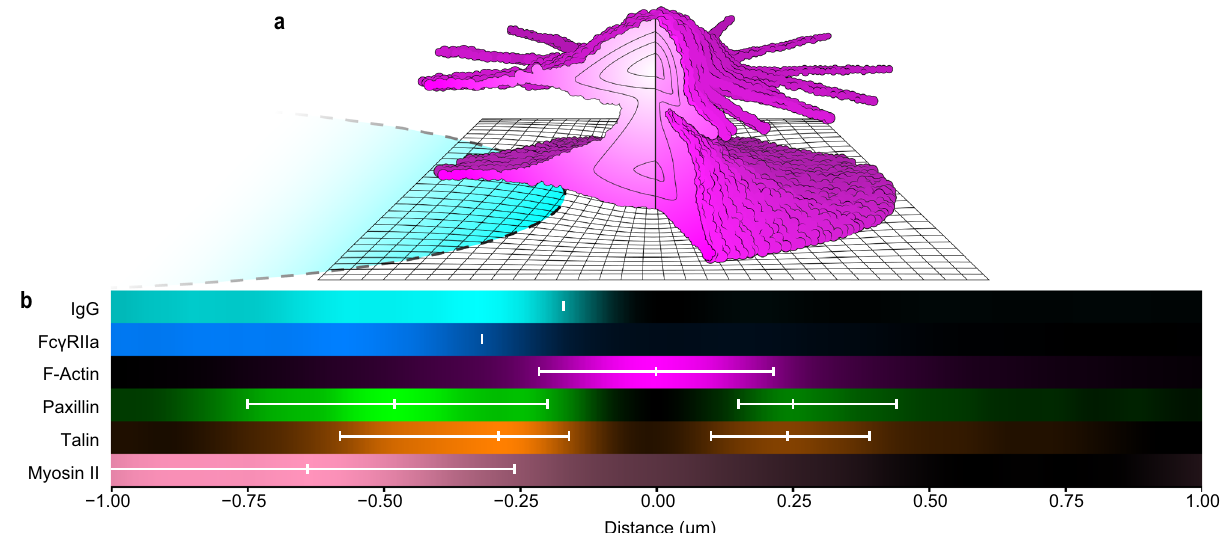
Fig. 9 | Schematic of podosome constituents drawn to scale. a Cartoon of actin (magenta) based on iPALM, showing upper radial fi bers, lower actin network, and the ventral protrusion. The cross-section shows intensity contours quanti fi ed in Fig.4e.The IgGdisk is shown incyan. Grid unitlength=50nm. b One-dimensional density plots from TIRF-SIM imaging of species centered on the F-actin peak. Plots correspond to the meanvaluesfor eachspecies in Fig. 1e (IgG and Fc γ RIIA),Fig. 7c